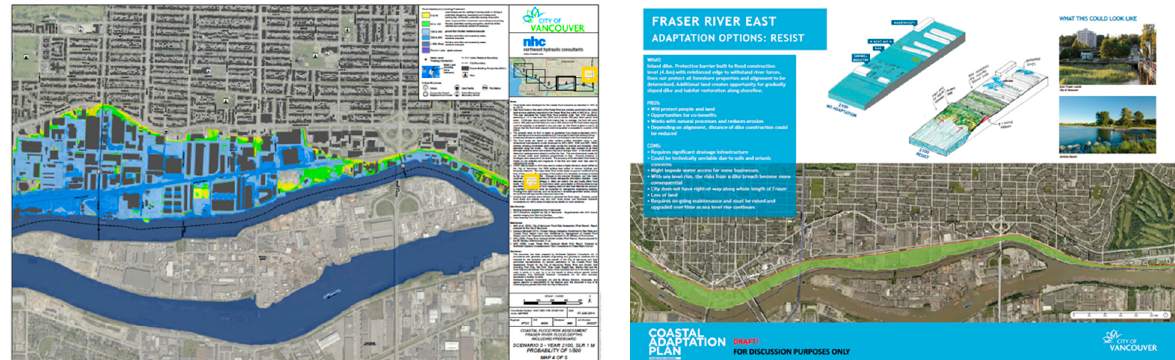
Figure 2. The documents published by the City of Vancouver provided guidance to the design of visualization, as well as the text and conceptual drawings used in the user interface. On the left , is a flood impact map, and the right document is an excerpt from the Coastal Adaptation plan describing various adaptation scenarios for the Fraser shore area.